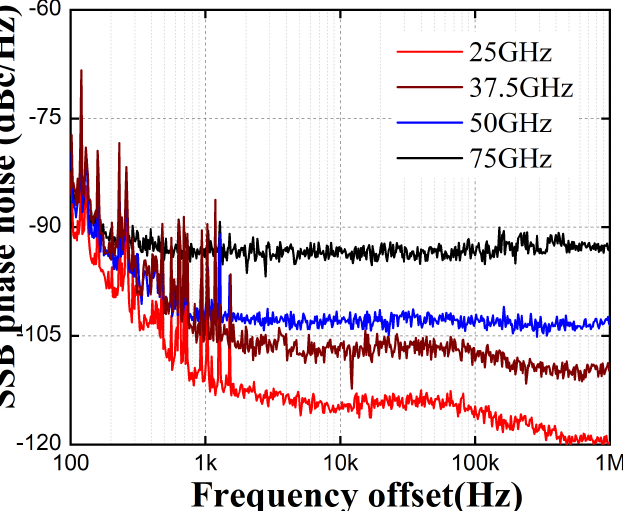
Figure 5. Single sideband (SSB) phase noise of the comparisons of the 25, 37.5, 50 and 75 GHz generated from different